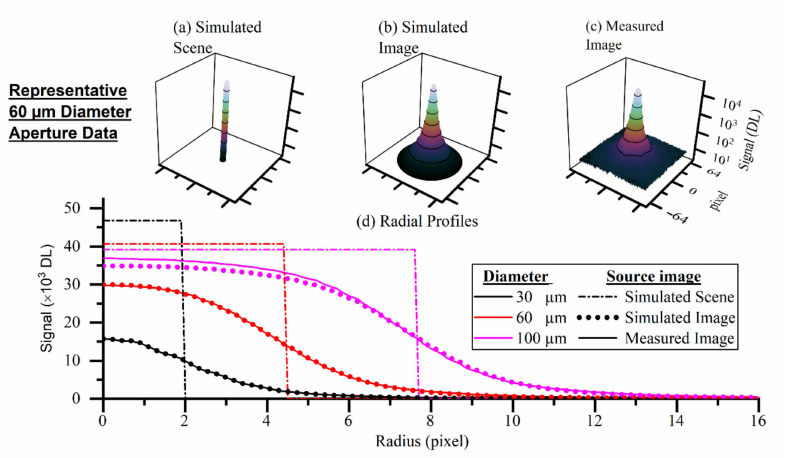
Figure 11. Representative data of the validation targets. ( a ) Fitted parameterized thermal field model; ( b ) convolution of ( a ) with the spatial transfer function of the thermographic instrument; ( c ) measured image of the 60 µ m aperture; ( d ) radial profiles of three of the pinhole measured images along with the radial profiles of their corresponding simulated scenes and simulated